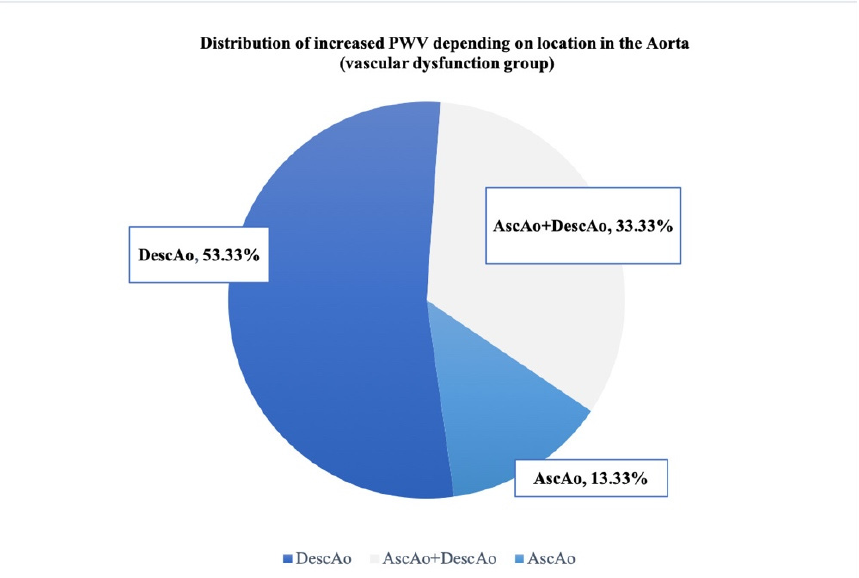
Figure 6. Distribution of increased PWV depending on location in the aorta (vascular dysfunction group).